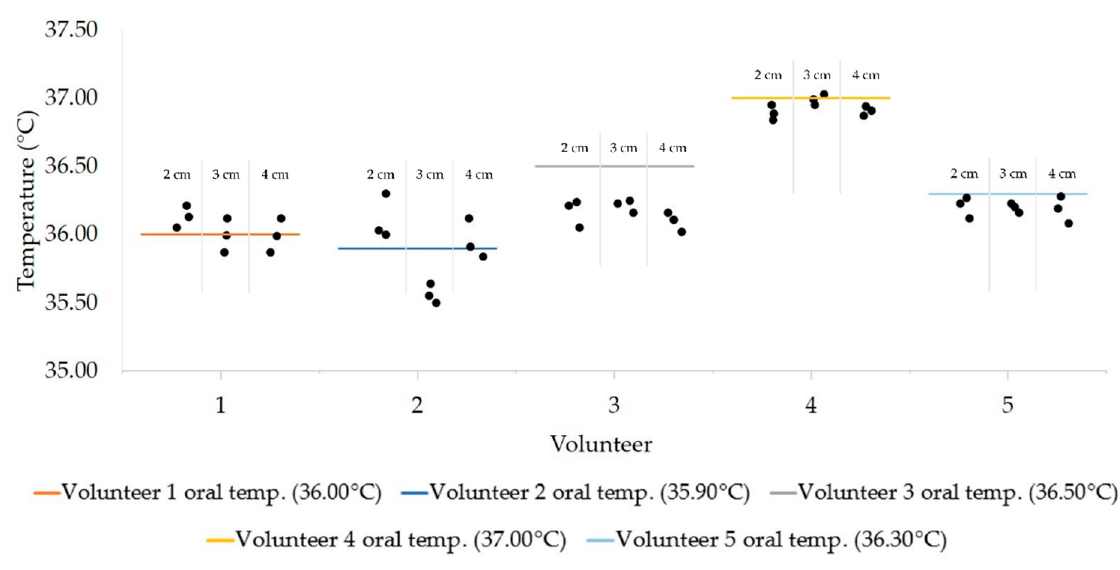
Figure 6. Recorded temperatures and the oral temperature for each volunteer. For each volunteer, the dots represent individual data points in the respective distance from the foreheads.